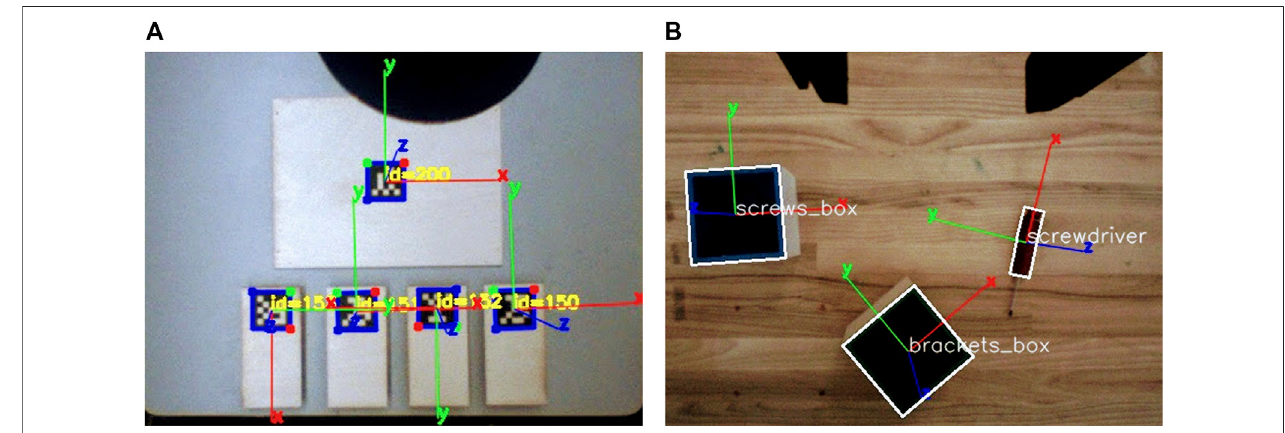
FIGURE 4 | Snapshot of the camera streams from the left and right end effectors (A,B) . The left arm uses a fi ducial marker tracking system based on Garrido- Jurado etal.(2014),whereastherightarmimplementstheHSV-based3Dreconstructionsoftwaredetailedin Section4.1.1 .See Section4.2 belowforadescriptionof the objects composing the construction